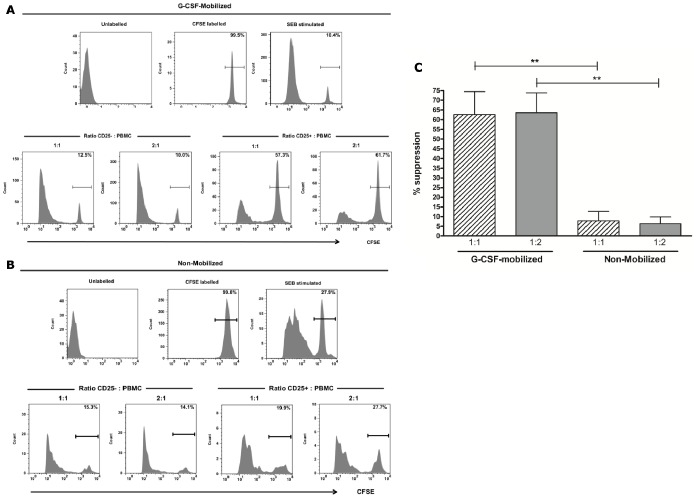
Suppression of autologous PBMCs by CMV-stimulated CD25+ cells isolated following CMVpp65 stimulation.Suppressive capacity was assessed in CD25-positive and CD25-negative fractions after magnetic selection following CMVpp65 stimulation between G-CSF-mobilized (A) and non-mobilized (B) donors. CFSE-labelled PBMCs were cultured at two ratios in the presence of SEB for 5 days. Cumulative data in G-CSF-mobilized (n = 5) and non-mobilized (n = 5) donors are shown at a ratio of 1∶1 (diagonal bars) and 1∶2 (shaded bars) PBMCs to CD25+ selected T cells after calculating percentage of suppression as indicated in the Material and Methods section. Data are presented as mean values with standard deviation (C). Unlabelled, PBMCs alone (CFSE) and PBMCs with SEB were cultured as experimental controls. **p<0.01, in an unpaired t test.